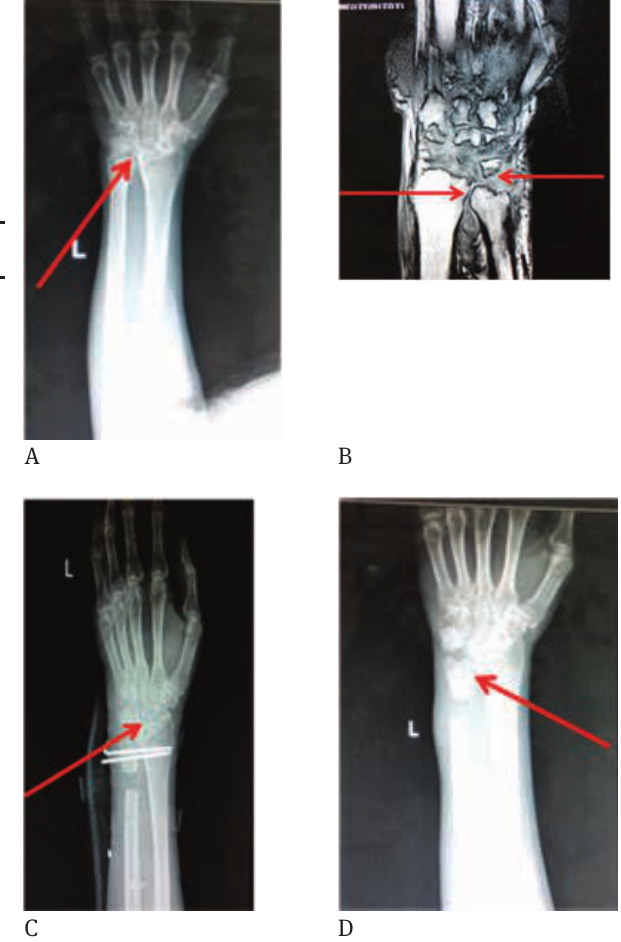
Figur e 1: Patient, male, 55 years old (a) Preoperative X-ray. Widened distal radioulnar joint space and uneven articular surface. (b) Preoperative nuclear magnetic resonance. Articular capsule have high signal area. (c) Radio logical result one d ay after the modified Sauve-Kapandji procedure. The joint surface is smooth and the joints are stable. (d) Radiological result 4 months after the modified Sauve-Kapandji procedure. The joint surface is smooth and the joints are